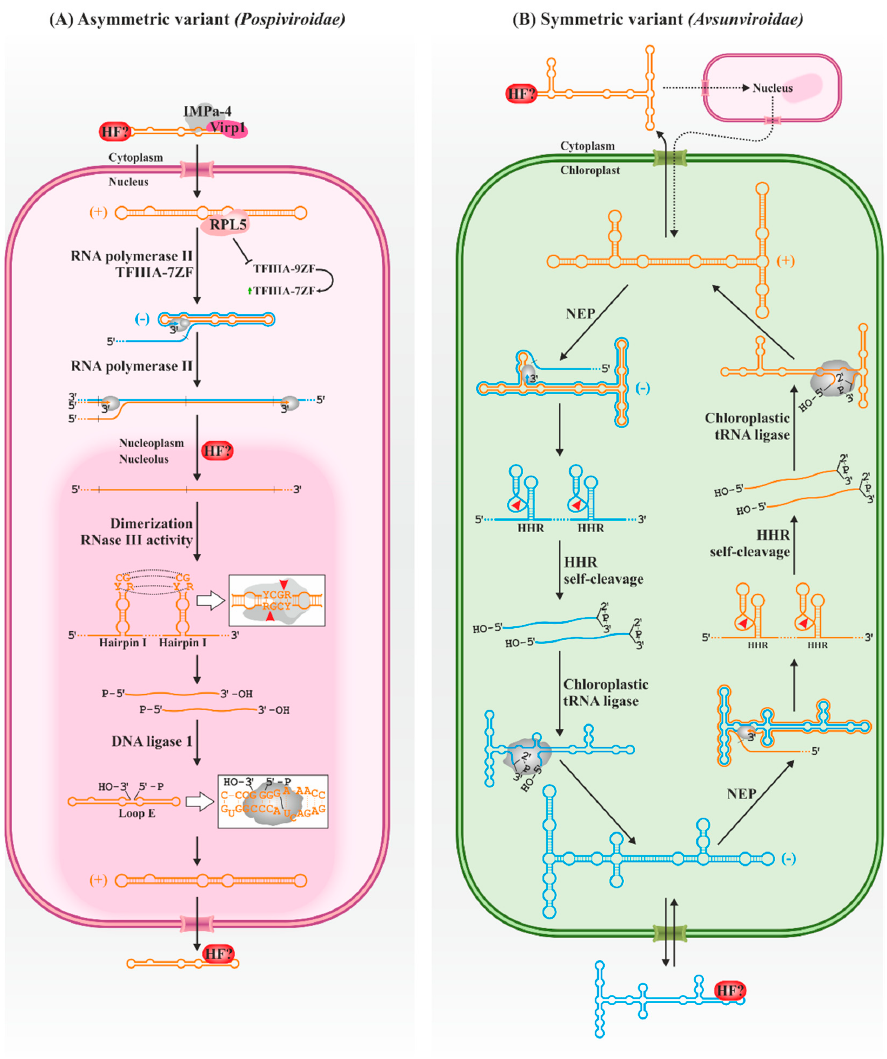
Figure 2. The rolling-circle mechanism in its ( A ) asymmetric and ( B ) symmetric variants is proposed for the replication of viroids of the families Pospiviroidae in the nucleus and Avsunviroidae in chloro- plasts, respectively. In both cases, the positive and negative viroid RNA polarities are represented in orange and blue, respectively. Host proteins and viroid RNA motifs involved in the replica- tive cycle are indicated. Arrowheads indicate RNA cleavage sites. -P, -OH and >P, 5 (cid:48) -phosphate, 5 (cid:48) -hydroxyl and 2 (cid:48) ,3 (cid:48) -phosphodiester groups, respectively; HF?, unknown host factor; HHR, ham- merhead ribozyme; IMPa-4, importin alpha-4; NEP, nuclear-encoded chloroplastic DNA-dependent RNA polymerase; RPL5, ribosomal protein L5; TFIIIA-7ZF/-9ZF, transcription factor IIIA splicing variants with seven or nine zinc fingers, respectively; and Virp-1, bromodomain-containing protein